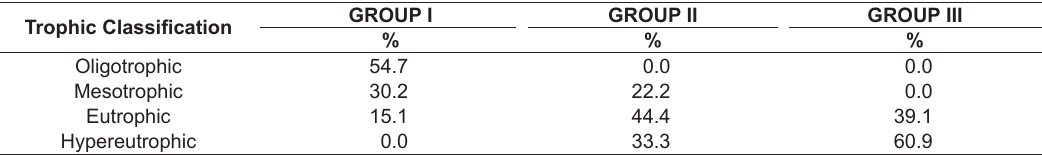
Table 6. Trophic classification of the groups of reservoirs by applying the TSI